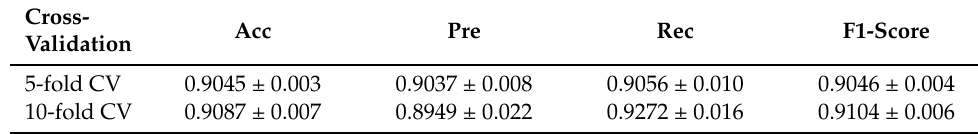
Table 1. The 5-fold and 10-fold cross-validation results of the SGAEMDA model.